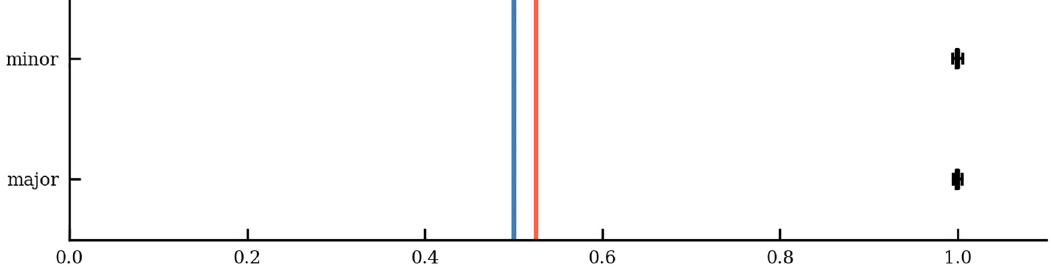
Fig 8. Mode symmetries. Mode symmetries for major and minor (blue and red vertical lines) and bootstrap resamples under the null hypothesis that chord progressions are symmetrical (histograms).